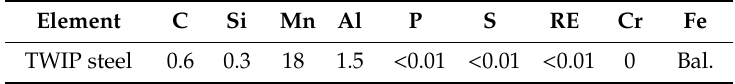
Table 1. The chemical composition of as-prepared twinning-induced plasticity (TWIP) steel (wt.%).